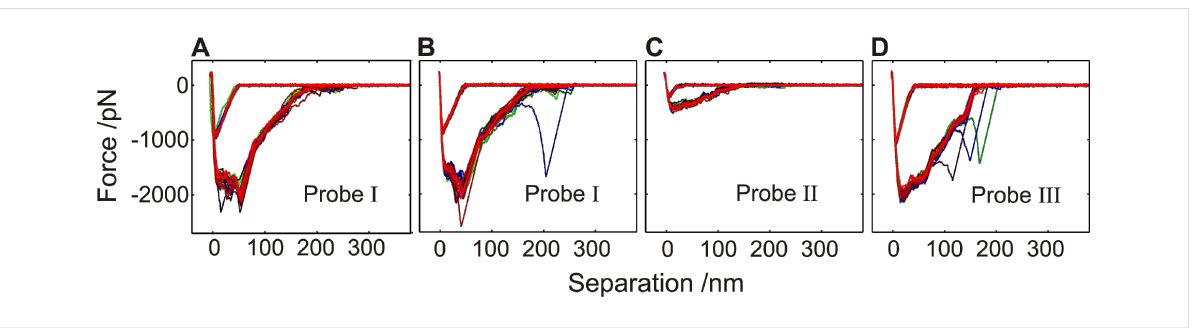
Figure 4: A–D: Overlay of 30 force/distance curves of three individual S. carnosus probes I, II and III on hydrophobic Si wafers, each with a force trigger of 150 pN. Between the experimental series shown in A and B, a set of 30 force/distance curves was taken with the identical bacterial probe on a hydrophilic Si wafer (not shown), yet the characteristic form of the second set of force/distance curves did not change